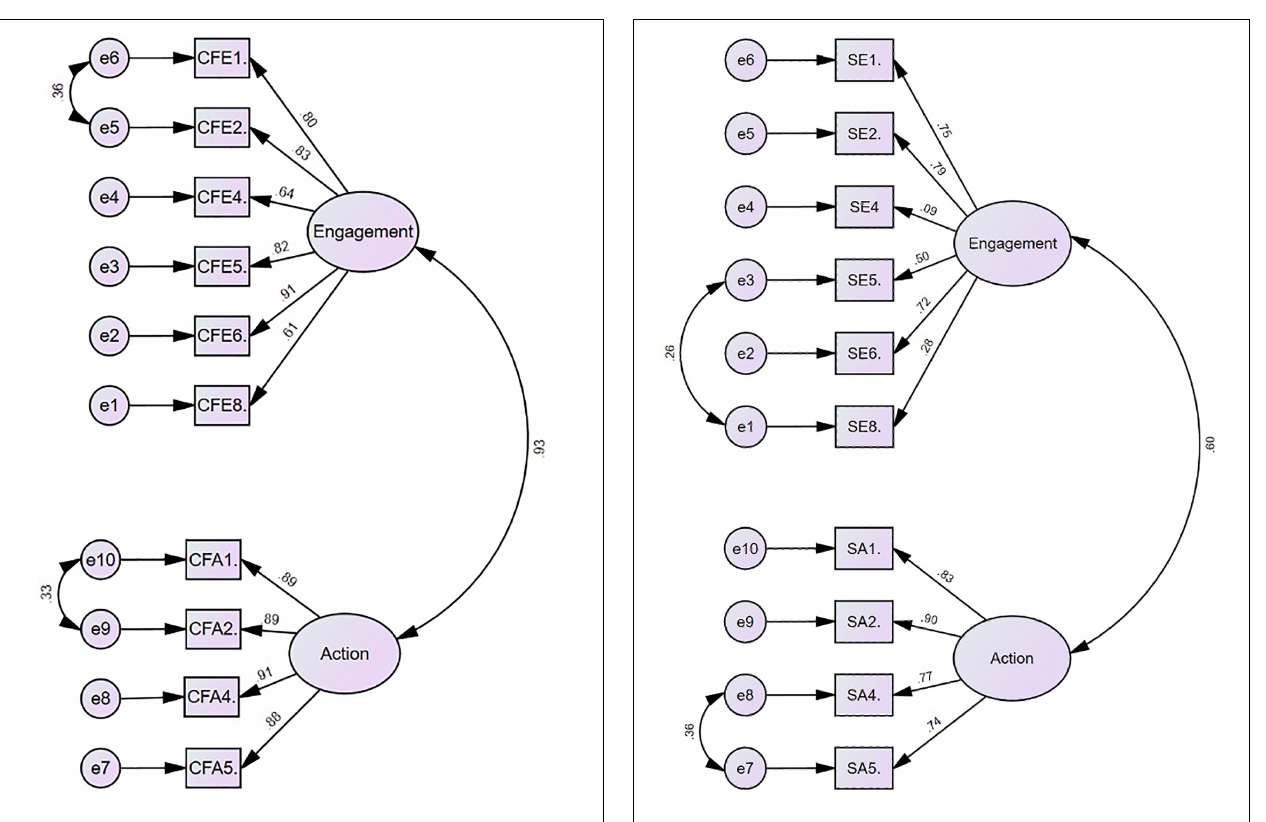
FIGURE 2 | CFA result of compassion from others. FIGURE 3 | CFA result of compassion for